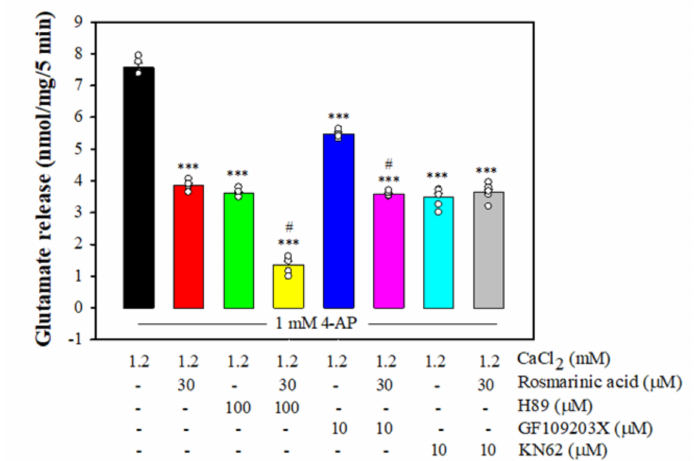
Figure 3. Effect of rosmarinic acid on 4-AP-evoked glutamate release in the presence of the PKA inhibitor H89, PKC inhibitor GF109203X or CaMKII inhibitor KN62. Rosmarinic acid was added